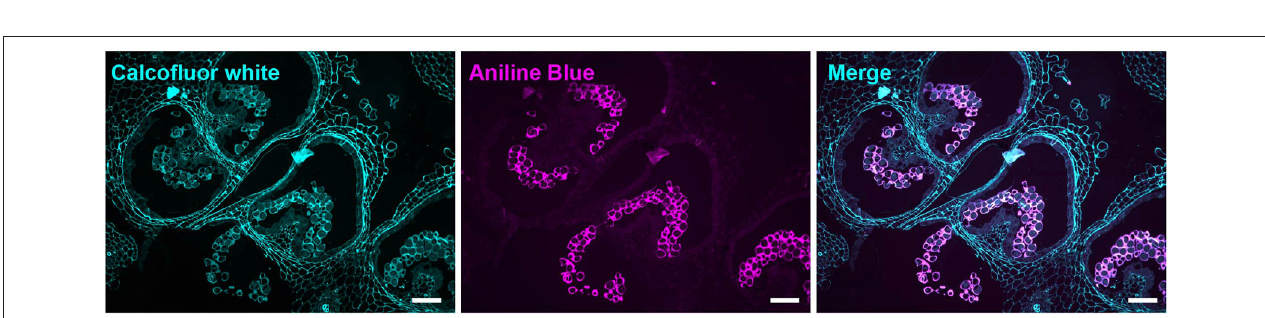
FIGURE 5 | Aniline blue staining of the tetrad callose wall. Fluorescent micrographs of anther cross sections (500nm) in LR white, of the 4-mm bud anther, stained with calcofluor white and aniline blue fluorochrome. Calcofluor white staining (cyan) (left). Aniline blue staining (magenta) (center). Merged staining (right). Scale bars 50 µ